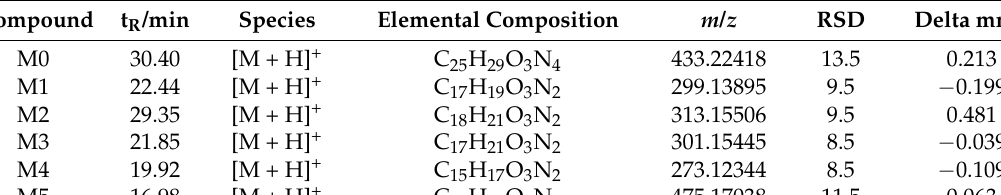
Table 1. Retention time, accurate mass, elementary composition, and precision of metabolites.